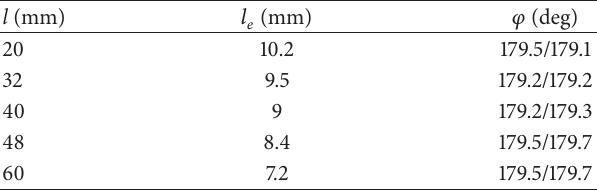
Table 1: Values of l and 𝑙 𝑒 with 180 deg phase